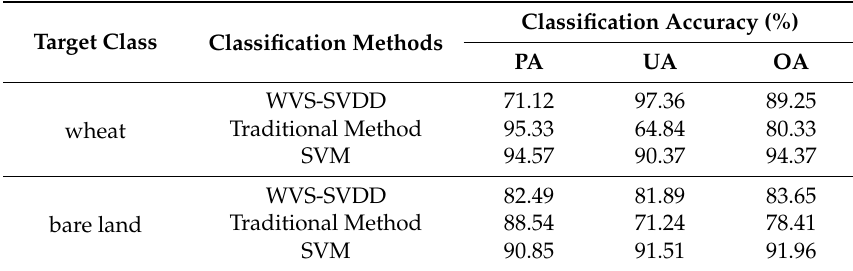
Figure 6. Comparison bare land classification results of different methods ( a ) Original remote sensing image; ( b ) reference result as actual data; ( c ) SVM classification result; ( d ) WVS-SVDD classification result; ( e ) traditional SVDD method. Table 2. Classification accuracy for the proposed, traditional and SVM methods. PA: producer’s accuracy; UA: user’s accuracy; OA: overall accuracy.